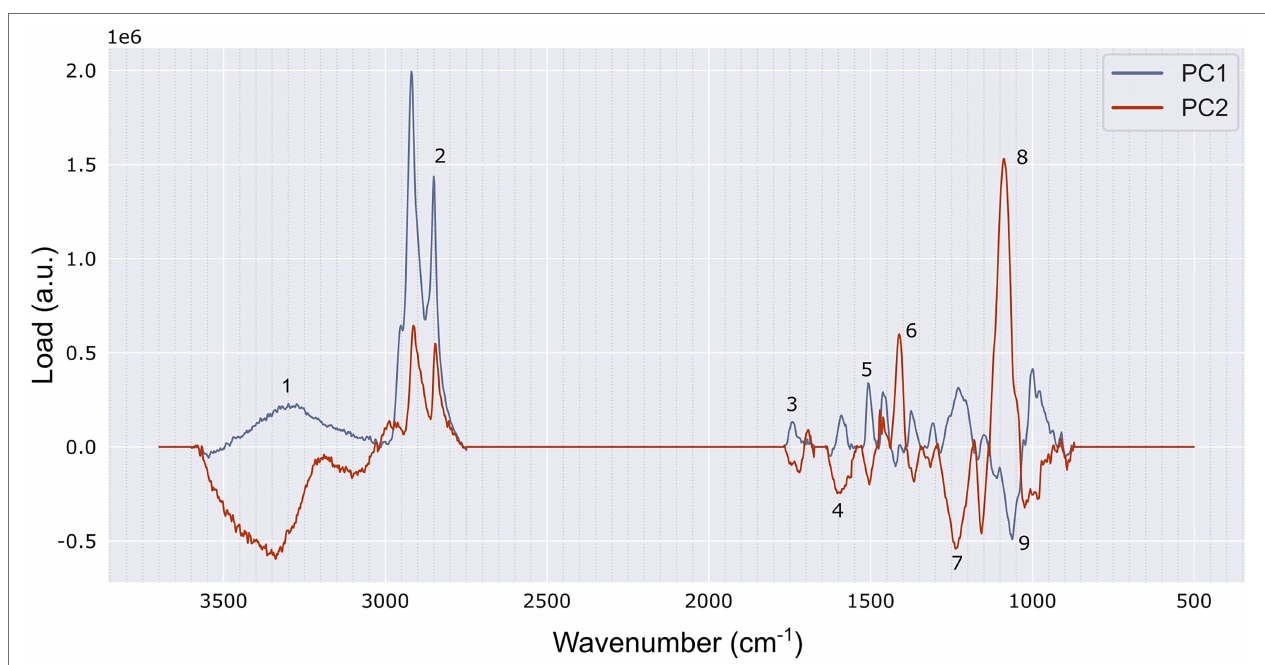
FIGURE 7 | Loading profiles of PC1 and PC2, with the bands that mostly contributed to the separation highlighted. (1) 3,300 cm − 1 assignable to OH stretching, (2) 2,848 and 2,918 cm − 1 associated with CH 2 stretching, (3) 1739 cm − 1 related to stretching vibrations in the O=C–OH group, for example of the glucuronic acid unit in the xylan (Guo et al., 2018), (4) 1,603 cm − 1 related to aromatic skeletal vibrations in lignin, (5) 1,507 cm − 1 related to asymmetric aryl stretching in lignin, (6) 1,412 cm − 1 related to HCC, HCO and HOC bending in cellulose, (7) 1,256 cm − 1 (observed at 1,240 cm − 1 ) tentatively assigned to CO stretching in lignin, (8) 1,088 cm − 1 related to COC, C–C and ring vibration in non-cellulosic polysaccharides (NCPs) and (9) 1,063 cm − 1 related to CC and CO stretching in cellulose (assignments based on Lupoi et al.,